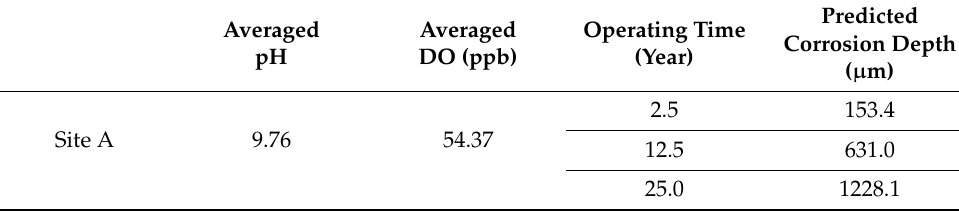
Figure 7. Actual monitoring data of pH and DO contained in DH water for 250 days. Table 7. Monitoring data and predicted corrosion depth.